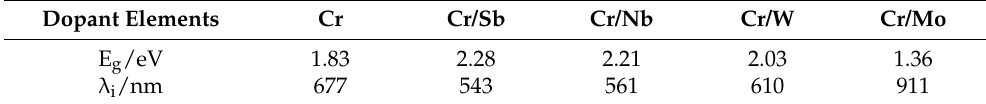
Table 2. Intrinsic absorption bandgap (E g ) and wavelength ( λ i ) of the doped TiO 2 pigments. Dopant Elements Cr Cr/Sb